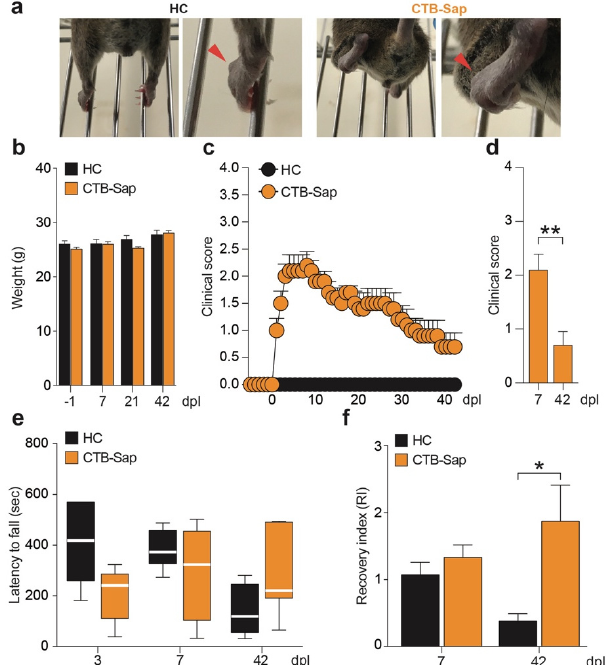
Figure 1. Behavioral impairment induced by selective spinal MN ablation. ( a ) Representative pictures of hindlimbs of HC and CTB-Sap lesioned mice; red arrows indicate the capability in HC or the lack of toes spreading of the left hindlimb of CTB-Sap mice; ( b ) HC and CTB-Sap mice body weight at − 1, 7, 21 and 42 day post lesion (dpl); data are shown as mean ± SEM; ( c , d ) clinical score during the time course of motor impairment ( c ) and bar plots at 7 and 42 dpl ( d ); data are shown as mean ± SEM; ** p -value < 0.01; unpaired t -test. ( e ) Latency to fall expressed in sec on rotarod test at 3, 7, and 42 dpl in HC and CTB-Sap lesioned mice; data are expressed as standard box-and-whiskers plot in which the central-line represents the median and the upper and lower bounds are min and max value; ( f ) recovery index (RI) of HC and CTB-Sap mice at 7 and 42 dpl over index at 3 dpl. Data are expressed as mean ± SEM; * p -value < 0.05; one-way ANOVA and Holm-Sidak’s multiple comparisons